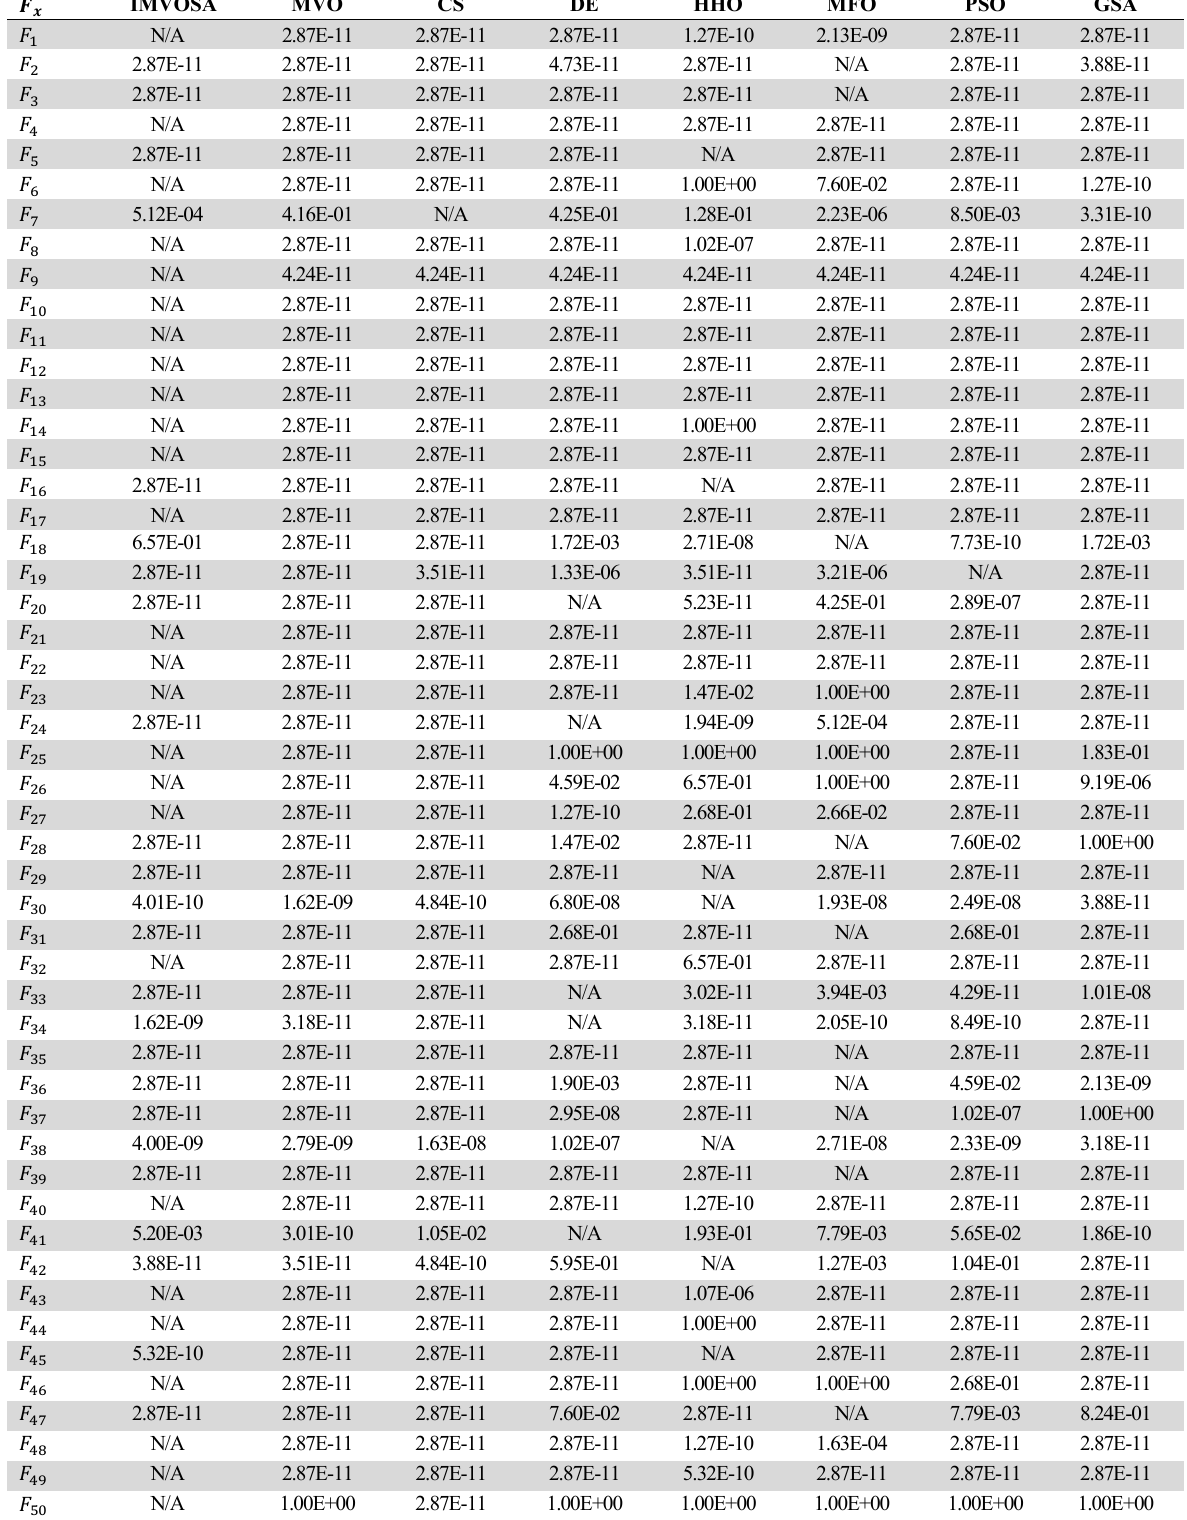
Wilcoxon rank sum test 𝑝 -values (N/A = not applicable) (continued overleaf) 𝑭